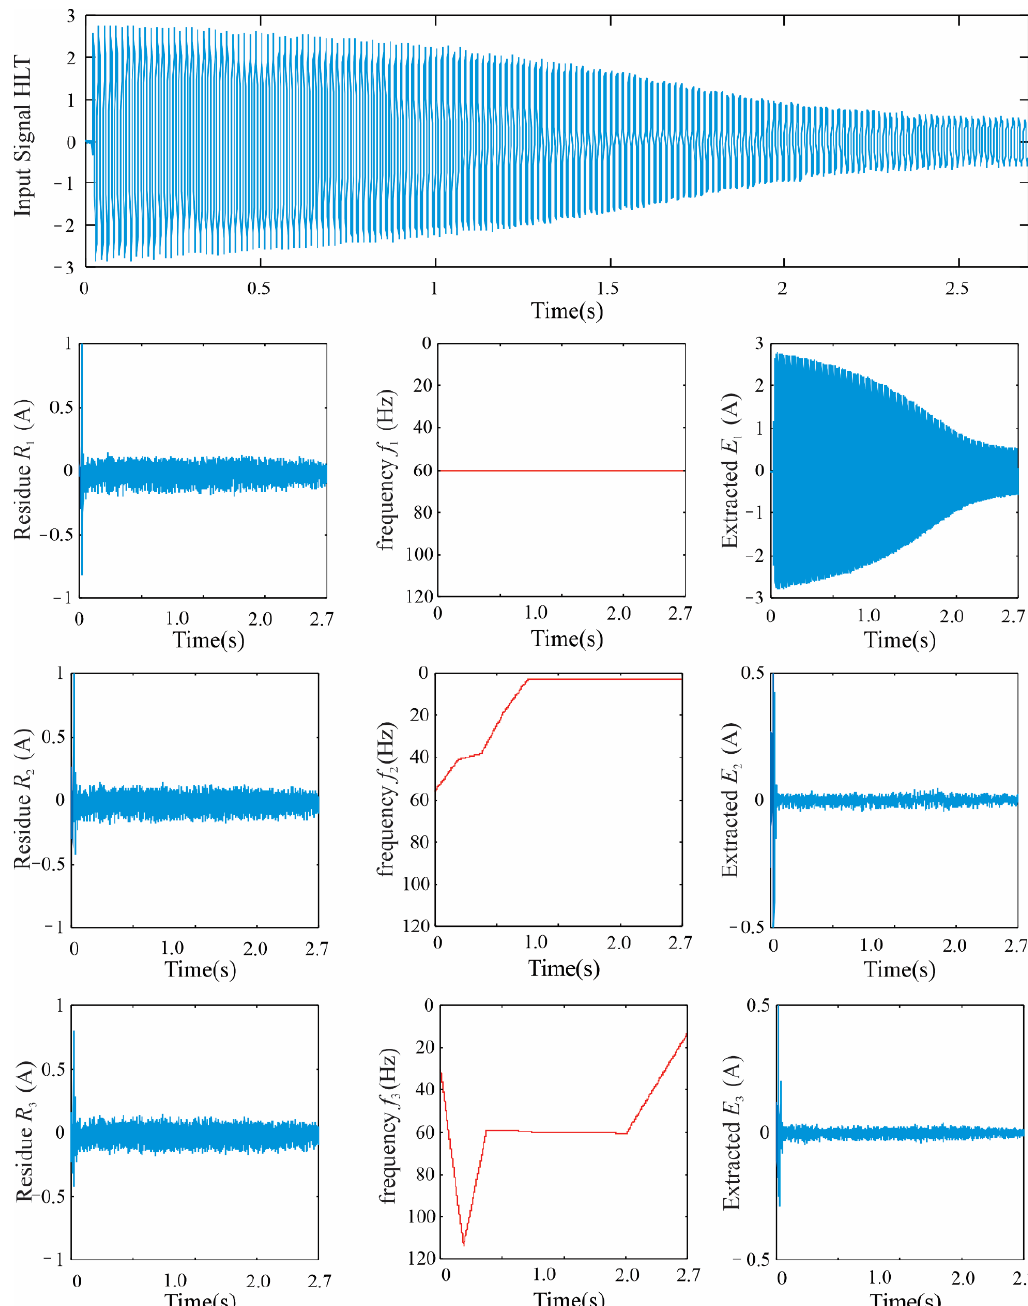
Figure 10. FBASD output for the HLT case.